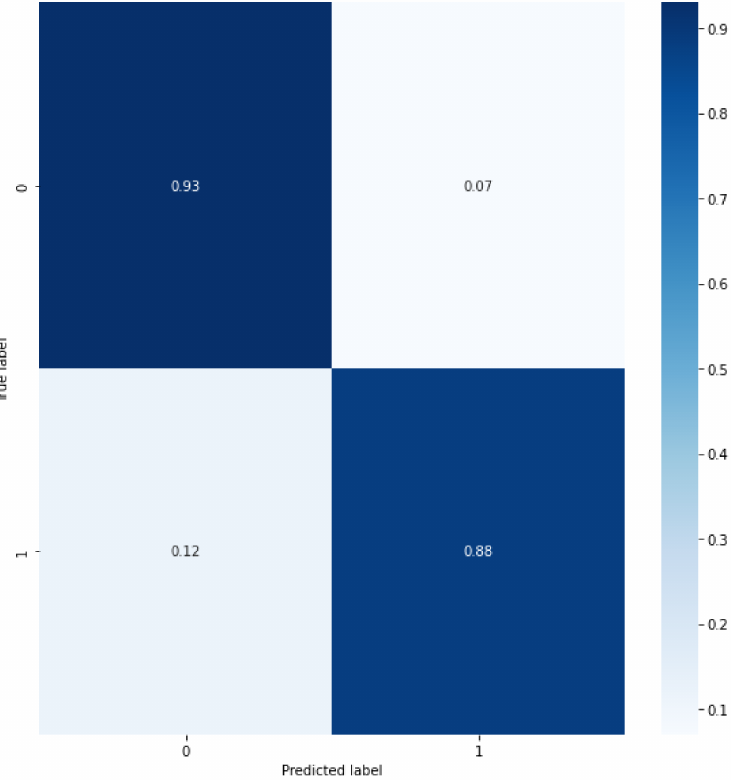
Figure 16. The result of the confusion matrix RNN. Table 9. The experiment results of the RNN model in every aspect of sentiment